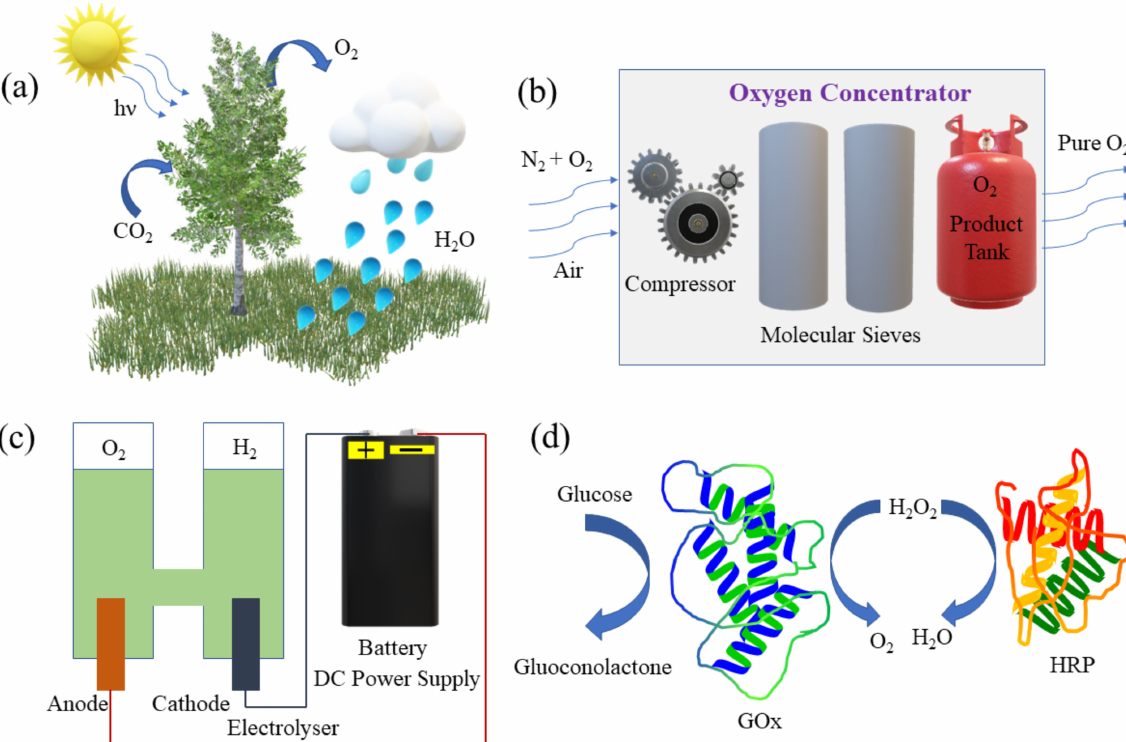
Figure 1. Schematic images of different oxygen generation methods. ( a ) Photosynthesis: plants convert carbon dioxide to produce oxygen. ( b ) A portable oxygen concentrator. ( c ) Water splitting reaction. ( d ) An example of enzymatic